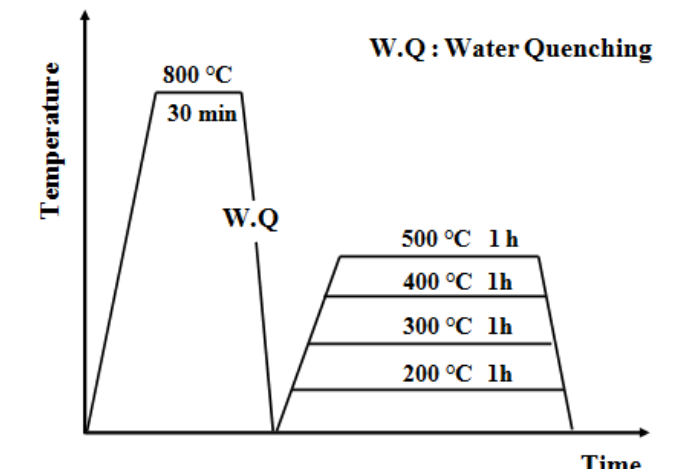
Fig. 1. Schematic illustration of the heat treatment